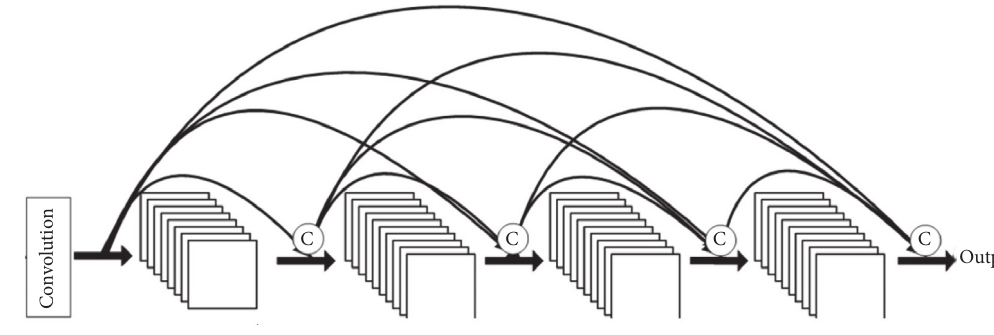
Figure 3: Schematic diagram of dense block in Densenet.